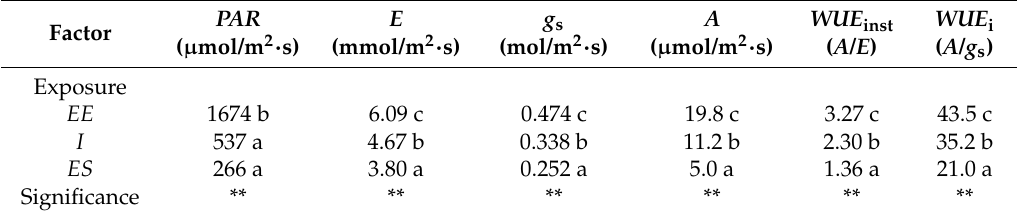
Table 2. Effect of leaf exposure ( EE , I , ES ) on leaf gas exchange and water use efficiency. Data taken 14 May. EE = exterior/exposed; I = interior; ES = exterior shaded.